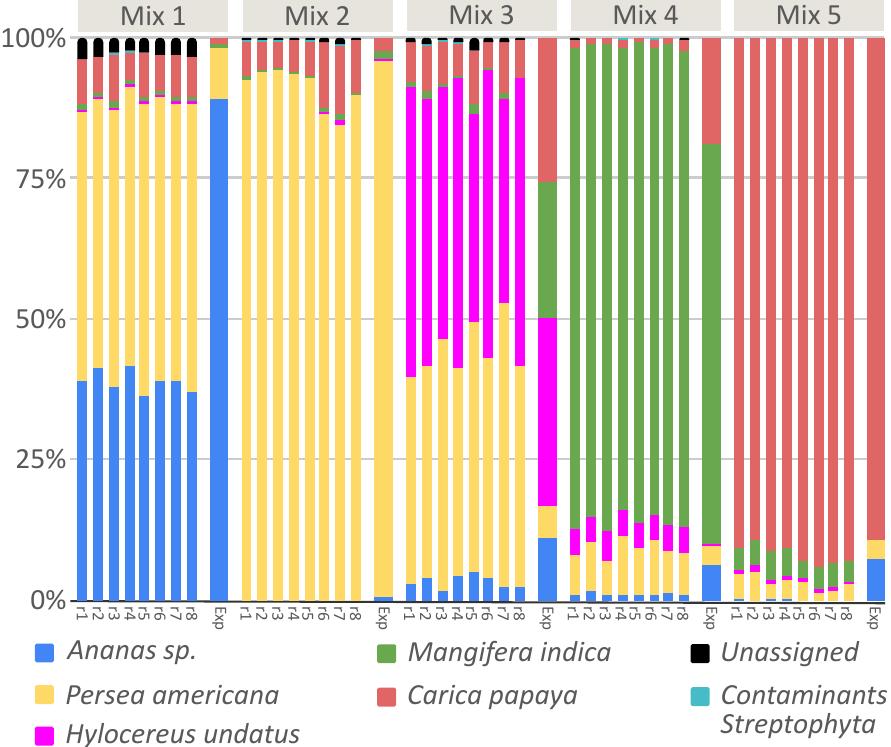
Figure 3. Taxa barplot reporting relative abundances of fruit detected in fruit mixtures, for each replicate. Exp represents the expected fruit proportion for each